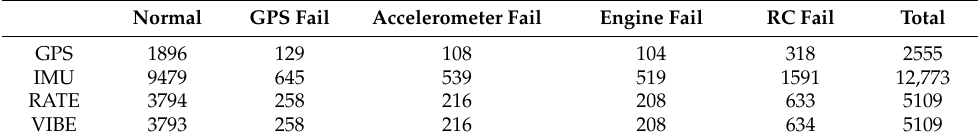
Table 7. Data distribution table for data before balancing treatment.